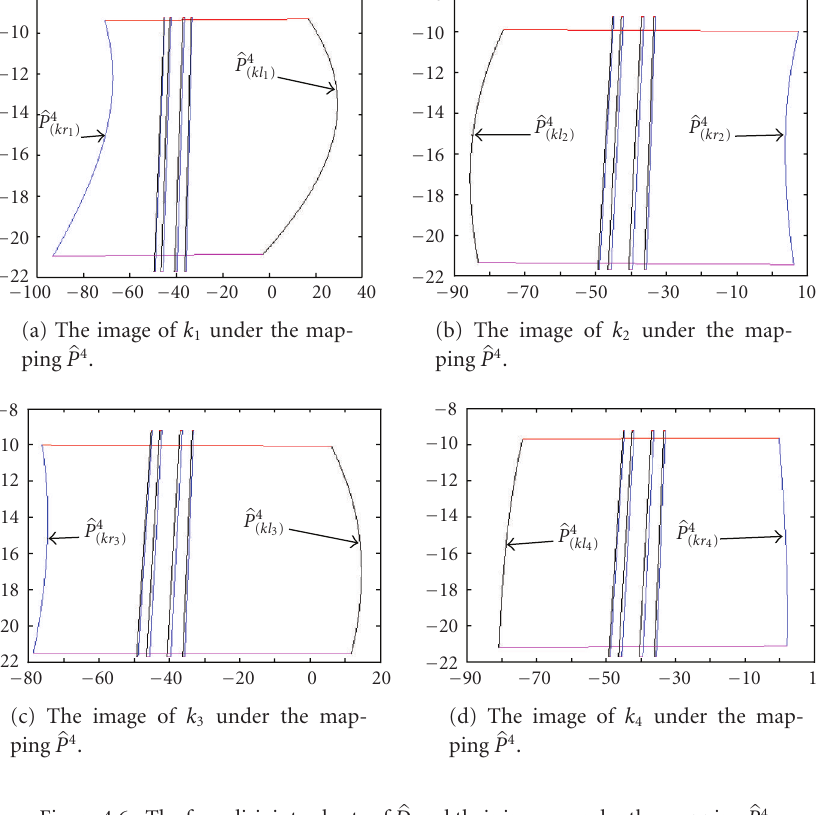
Figure 4.6. The four disjoint subsets of (cid:2) D and their images under the mapping (cid:2) P 4